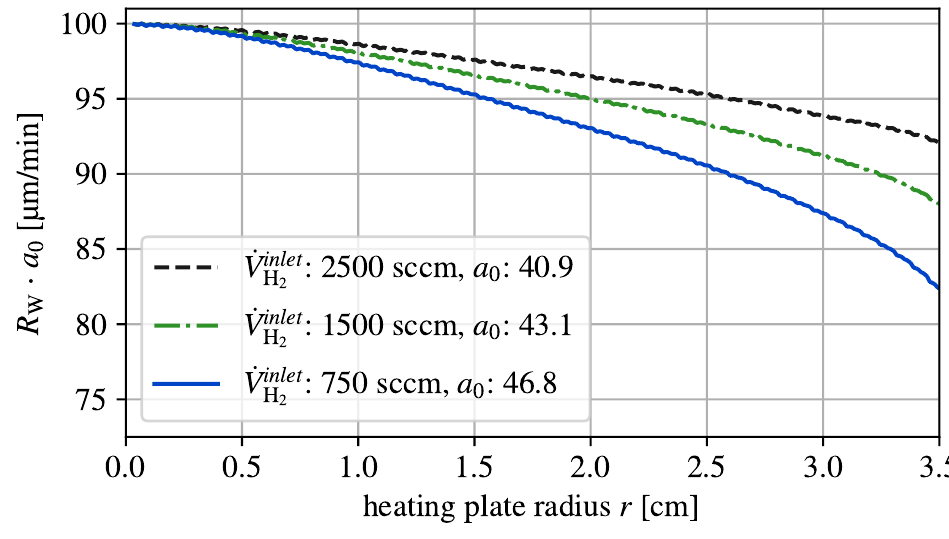
with T = 773 K, ˙ V inlet = 300 sccm, P tot = 12 kPa (otherwise, same caption H 2 WF 6